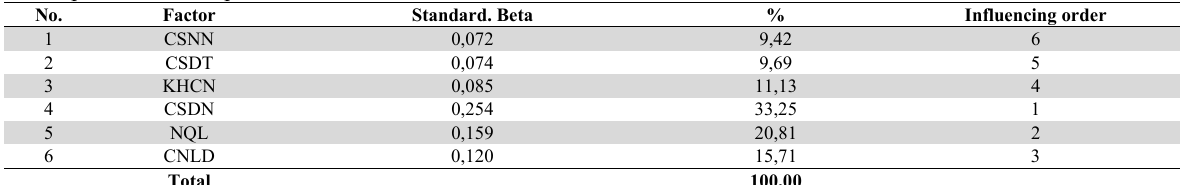
The importance of independent variables